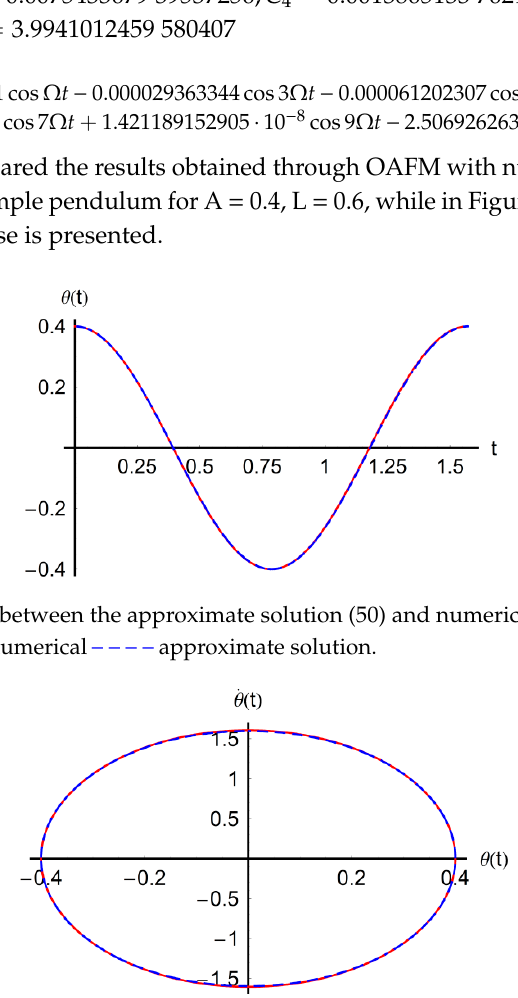
Figure 21. Phase plane for A = 0.4, L = 0.6. _____ numerical_ _ _ _approximate solution (50).